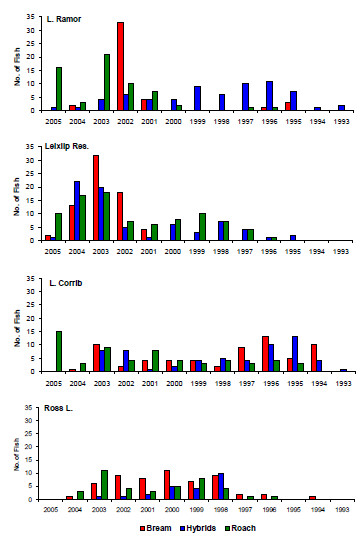
Landmarks used for morphometric analysis. Configuration of landmarks (black circles) collected on bream (in the picture), roach and their hybrid. (1) Snout tip; (2) posterior extremity of the premaxillar; (3) nostrils; left (4) and right (5) extremes of the eye; (6) insertion of the operculum on the lateral profile; (7) point of maximum extension of the operculum on the lateral profile; (8) extremity of the operculum; (9) anterior insertion of the dorsal fin; superior (10) and inferior (12) insertion of the caudal fin; (11) posterior body extremity; (13) anterior insertion of the anal fin; (14) anus; (15) insertion of the pelvic fin; superior (16) and inferior (17) insertions of the pectoral fin.